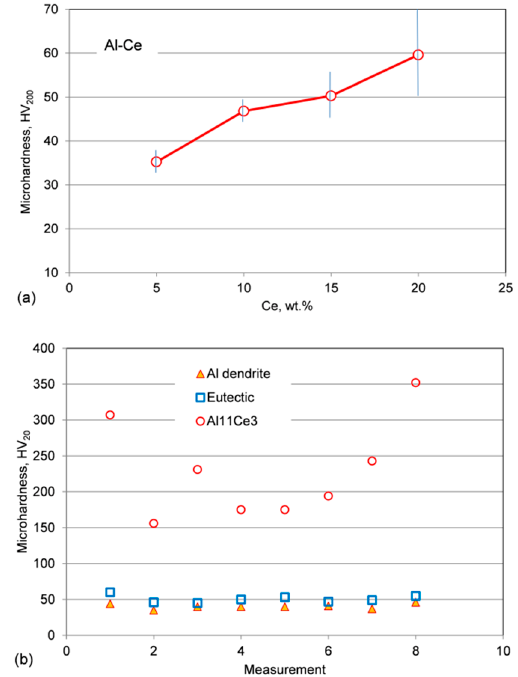
Figure 19. Microhardness of the Al–Ce alloys and their microstructural components: ( a ) effect of Ce content on the average microhardness of as-cast Al–Ce alloys; and ( b ) microhardness scatter of Al dendrites, the Al 11 Ce 3 phase and the Al–Al 11 Ce 3 eutectic.